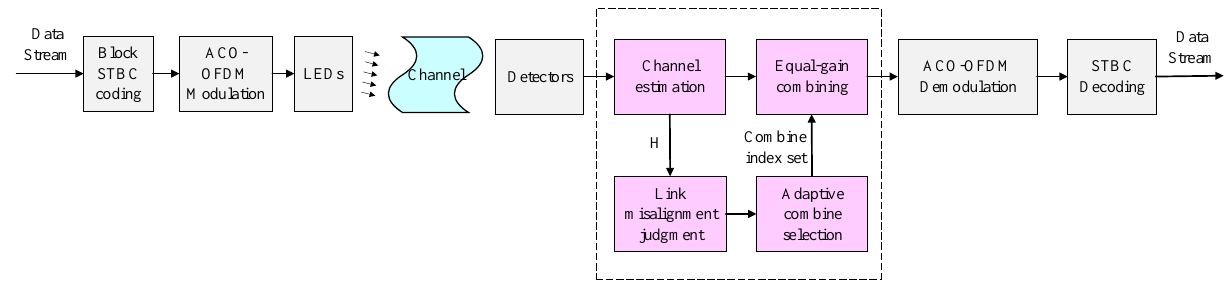
Figure 6. Adaptive diversity system block diagram.